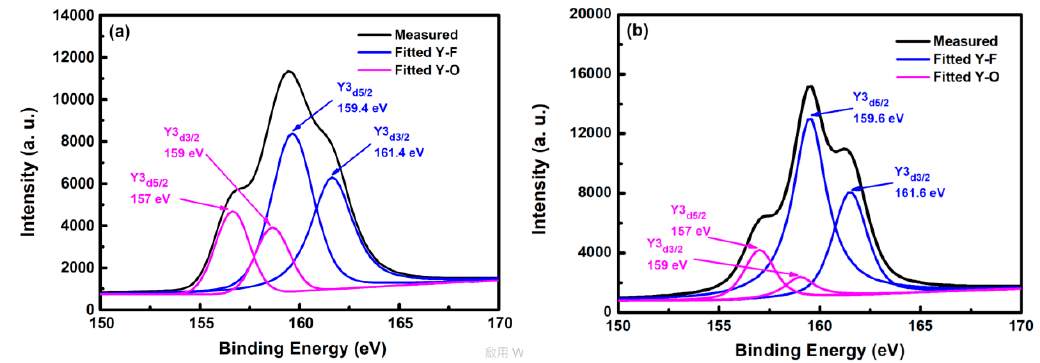
Figure 5. X-ray photoelectron spectra of YF 3 film ( a ) before and ( b ) after exposure to fluorocarbon plasma.